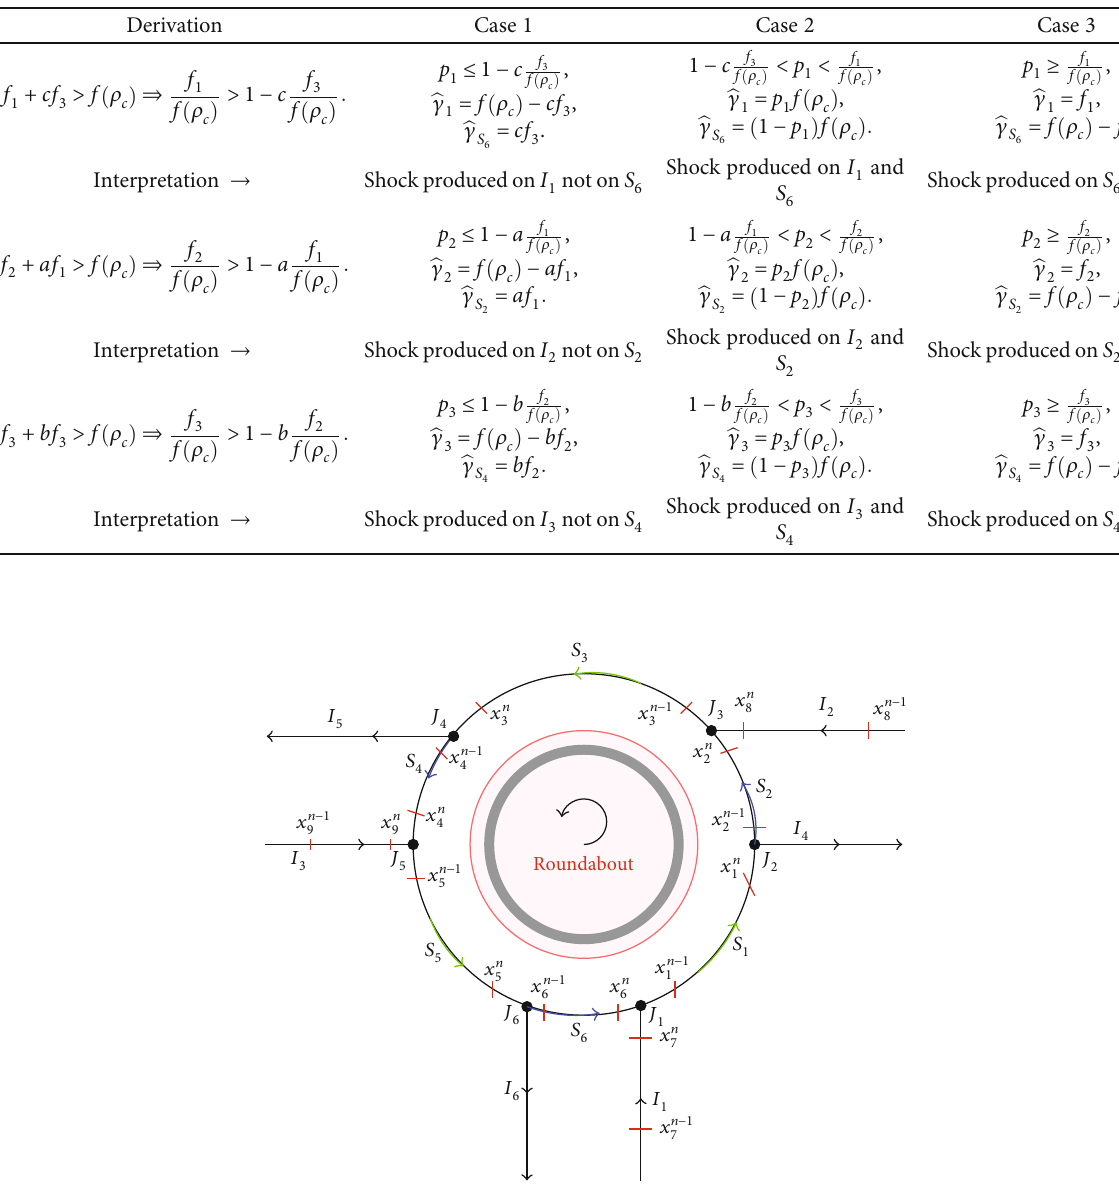
Figure 5: Wave junction intersections on the network of a roundabout.